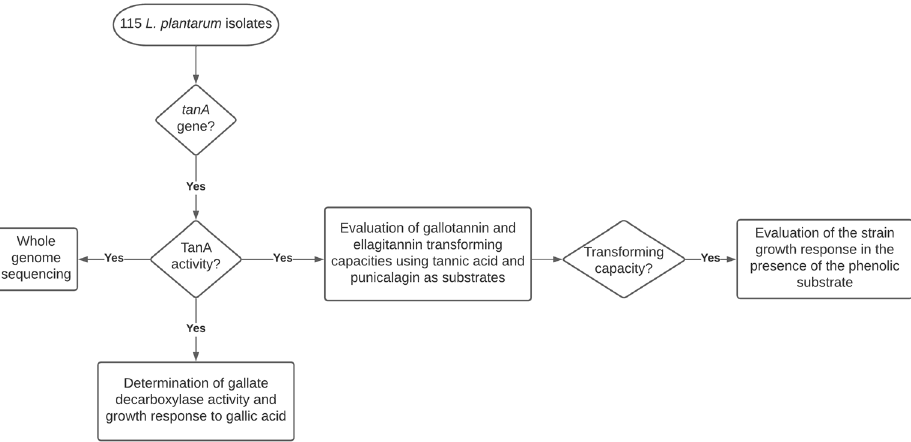
Figure 1. Flow diagram of L. plantarum screening, sequencing, and the evaluation of the strain metabolic activities and growth responses in the presence of